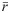
A) Similarity matrix between the whole-brain maps of r‾ values obtained with MVPD for each participant reflecting the statistical dependence between each voxel and the first, second, and third PC respectively in the FFA seed. B) Top 5000 voxels showing highest r‾ values for the first PC (in yellow), and for the second and third PCs (in blue). Different subspaces of FFA responses show different MVPD profiles, with the first dimension showing greatest statistical dependence with posterior ventral temporal regions and regions in the dorsal visual stream, and the second and third dimensions showing greatest statistical dependence with anterior temporal regions.